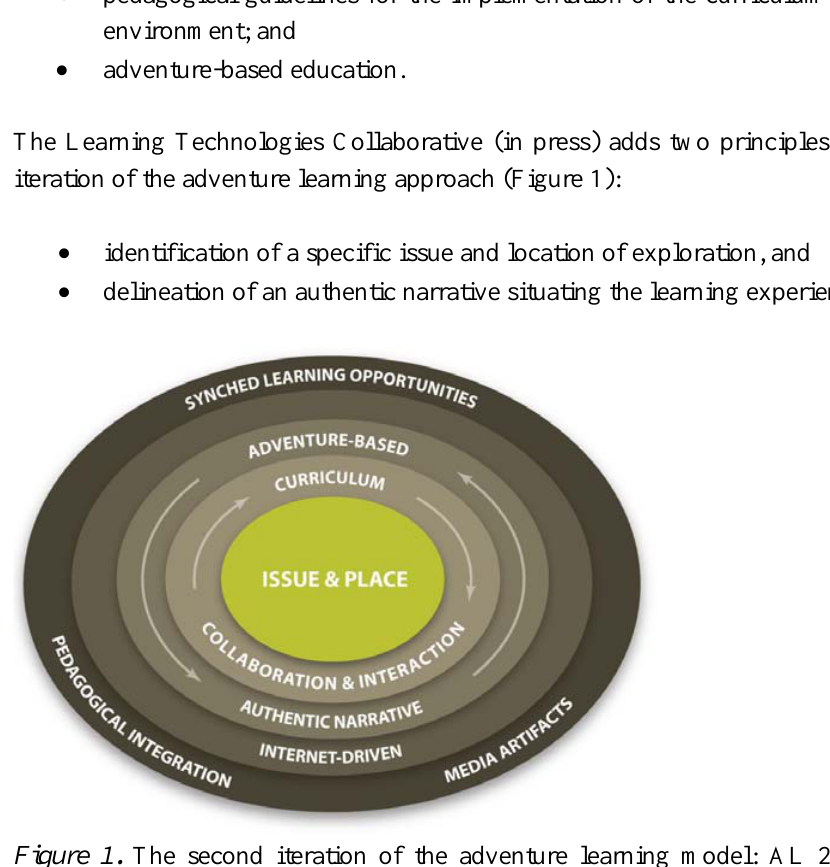
Figure 1. The second iteration of the adventure learning model: AL 2.0 (from The Learning Technologies Collaborative, in